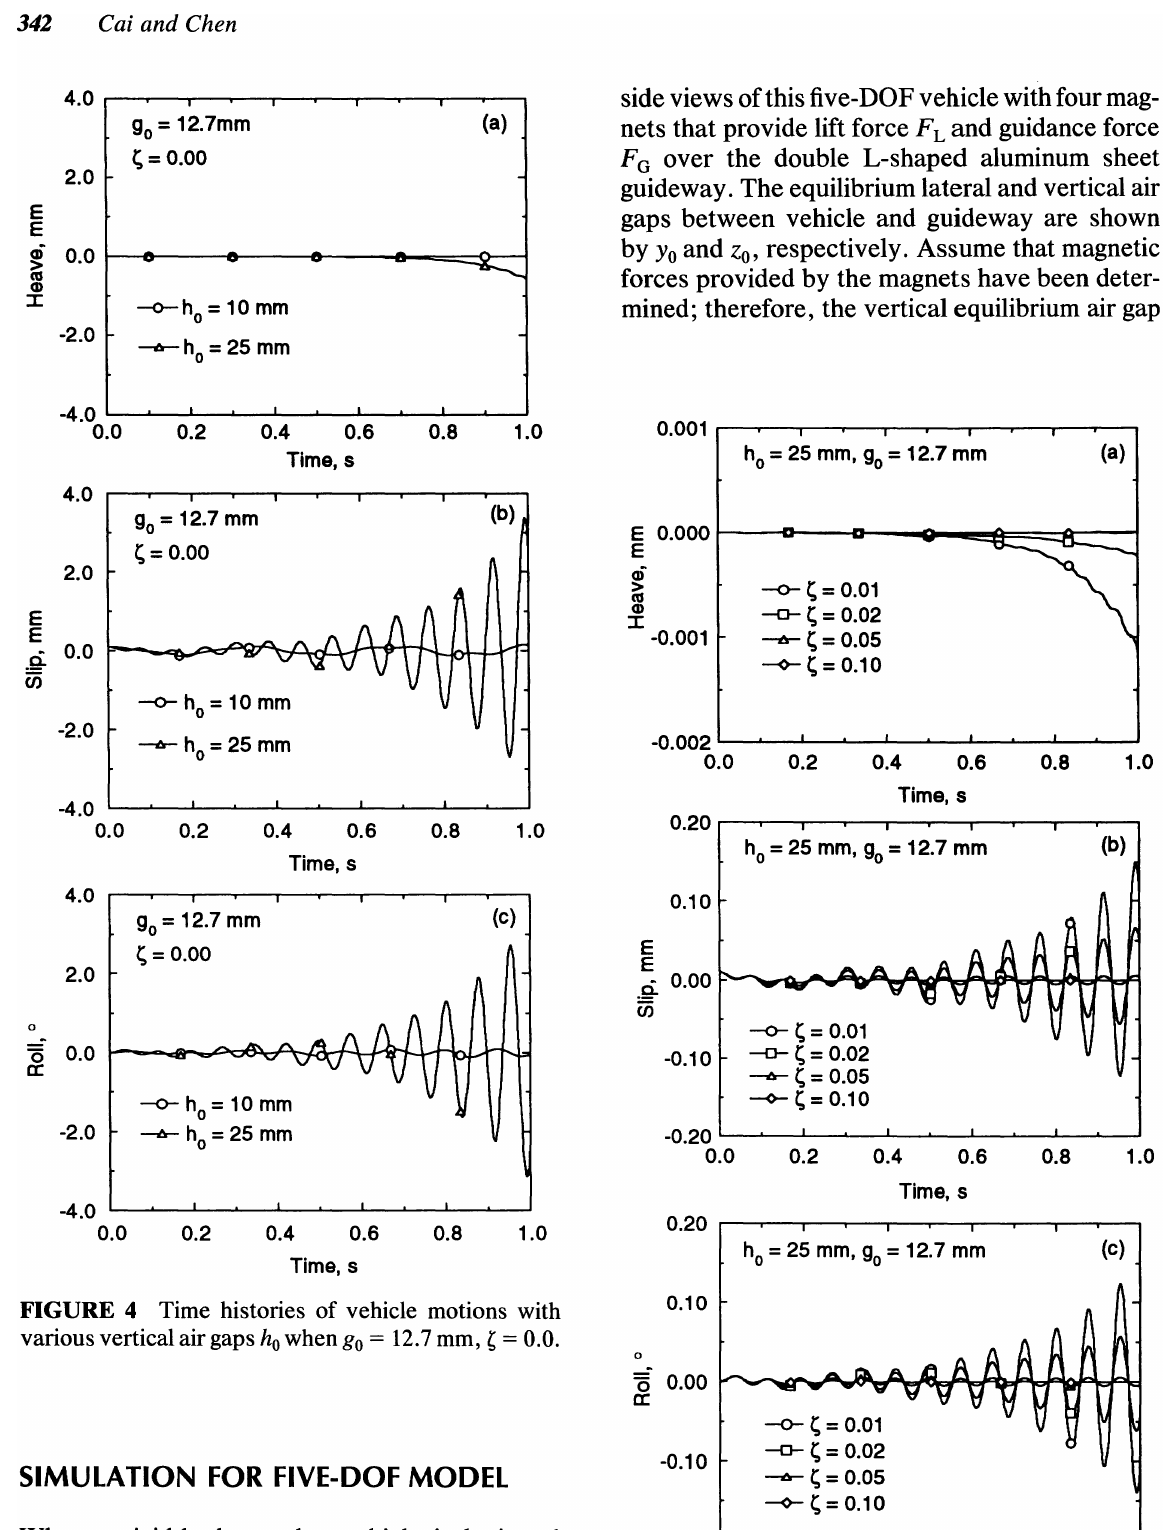
FIGURE 5 Time histories of vehicle motions with various damping coefficients when" ho = 25 mm, go = 12.7